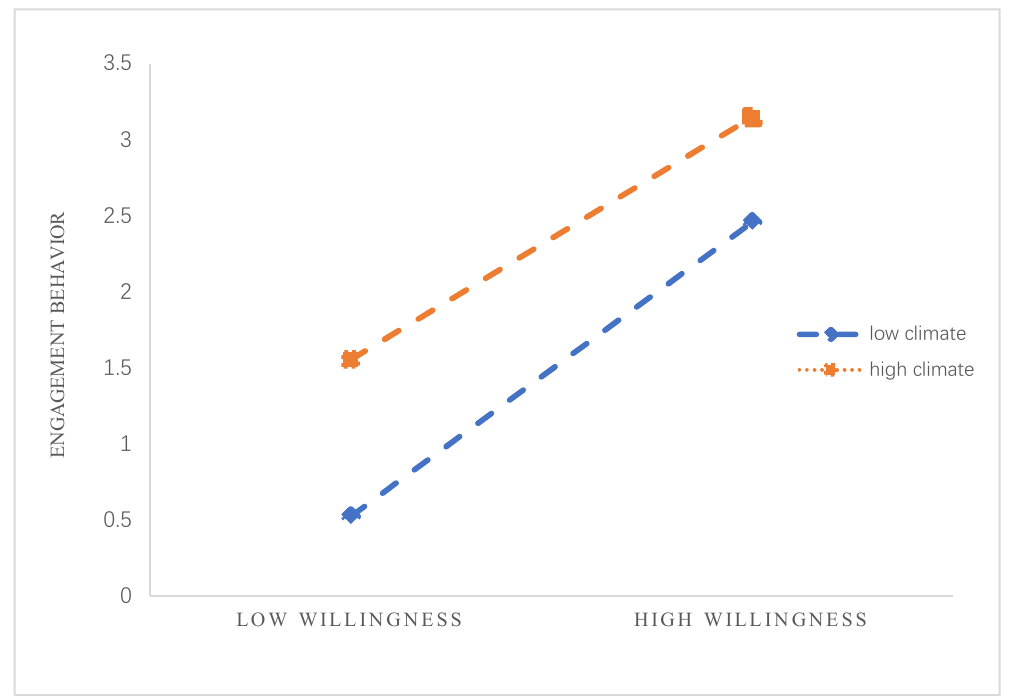
Figure 5. Moderating effect of involvement climate. Table 9. Test for moderating effect of involvement climate.